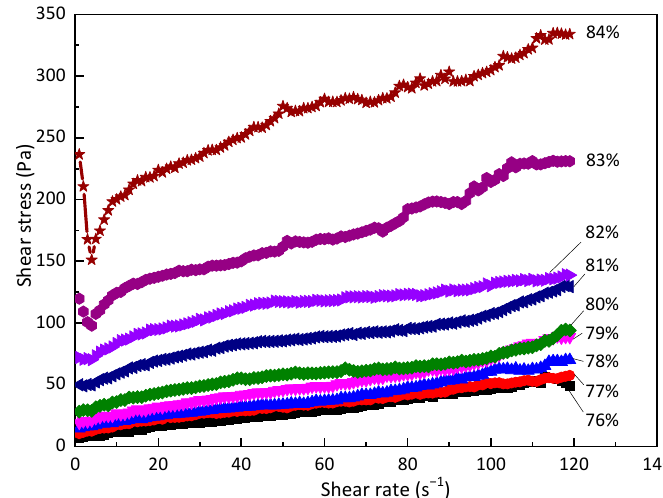
Table 1. Rheological parameters based on the flow curve fitting by Bingham model.